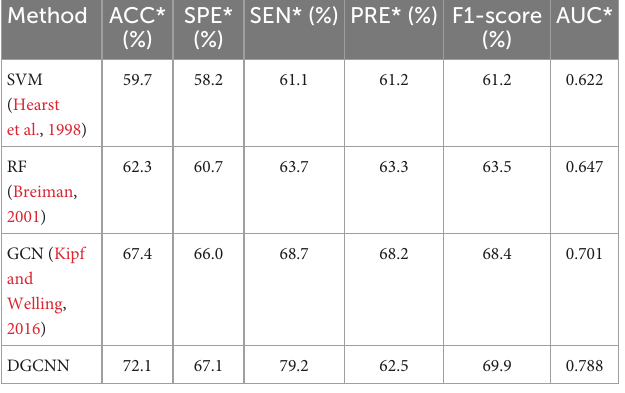
TABLE 3 Comparison of classification performance indexes of different classification methods in MDD dataset.